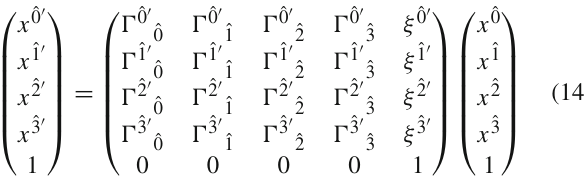
g μν Q where g μν Q μν = Q and 4